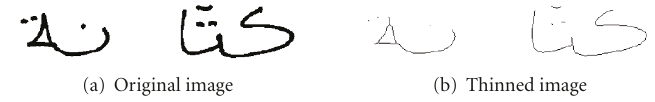
Figure 3: Result of the thinning algorithm.